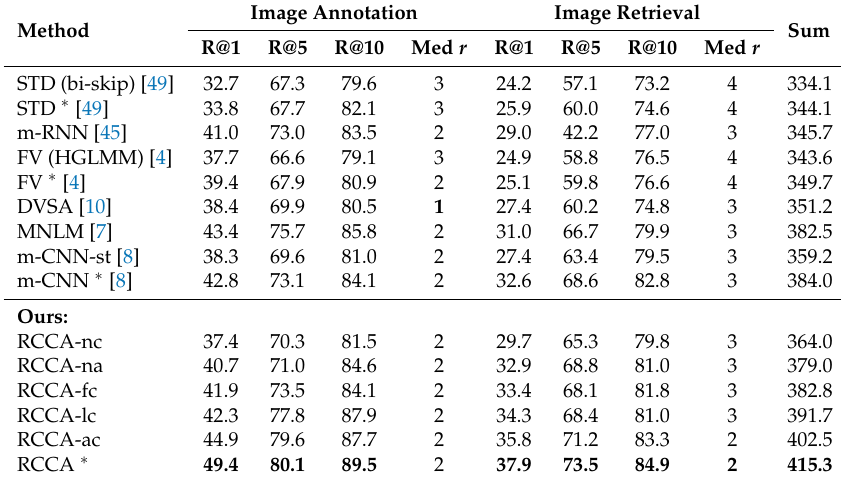
Table 3. Comparison results of image annotation and retrieval on the Microsoft COCO dataset ( ∗ indicates ensemble or multi-model methods).